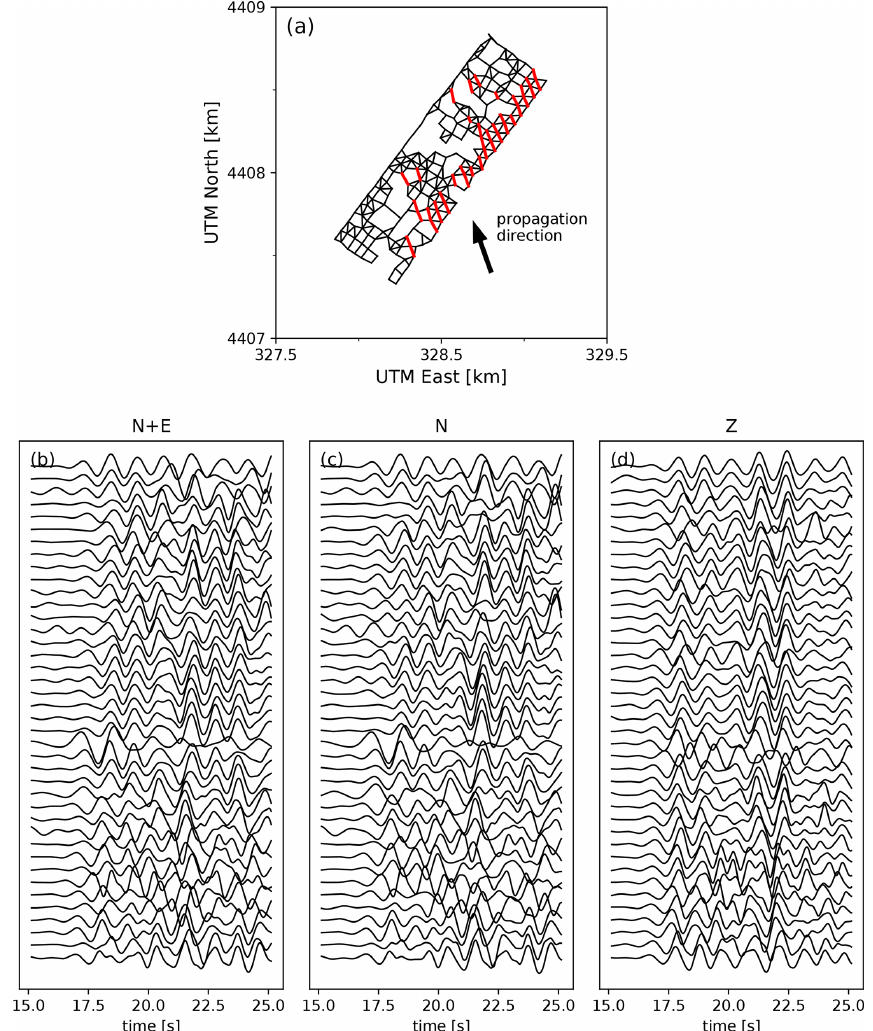
Figure 8. (a) Layout of the virtual DAS array, defined by the edges connecting two nodal seismometers separated by less than 80m in distance. The propagation direction of the wavefield is included for reference; (b–d) P waveforms recorded by the virtual DAS array for segments with an orientation ± 10 ◦ with respect to the back-azimuth of the seismic source (indicated in red in a ), ordered by distance from the seismic source, filtered in a 0.5–1Hz pass band, and scaled by the standard deviation of each trace. In (b) , the waveforms are a superposition of the N and E components of the nodal seismometers, while in (c) and (d) only the N and Z components are used,